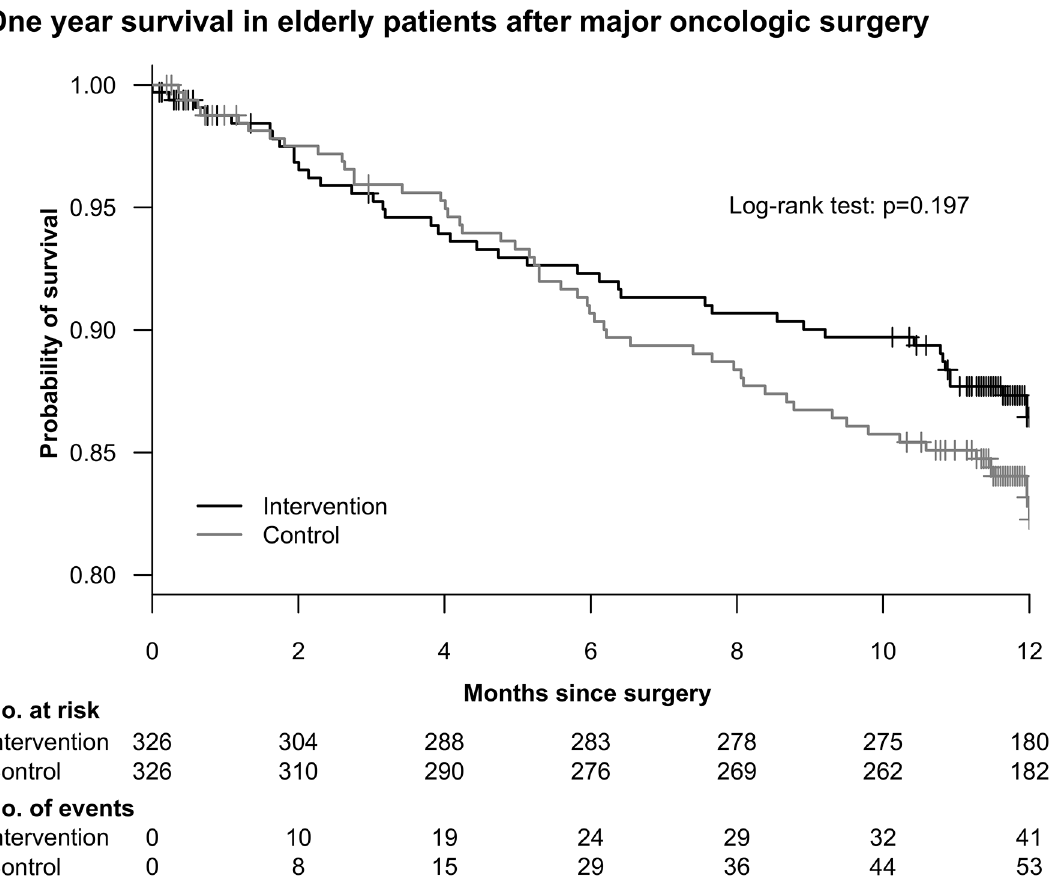
Fig 7. Kaplan Meier Estimation of Survival in intervention and control groups. Patients were followed up to one year after surgery. After 12 months 103 (15.8%) patients had died. Mortality did not differ between intervention and control groups (log rank p = 0.197).